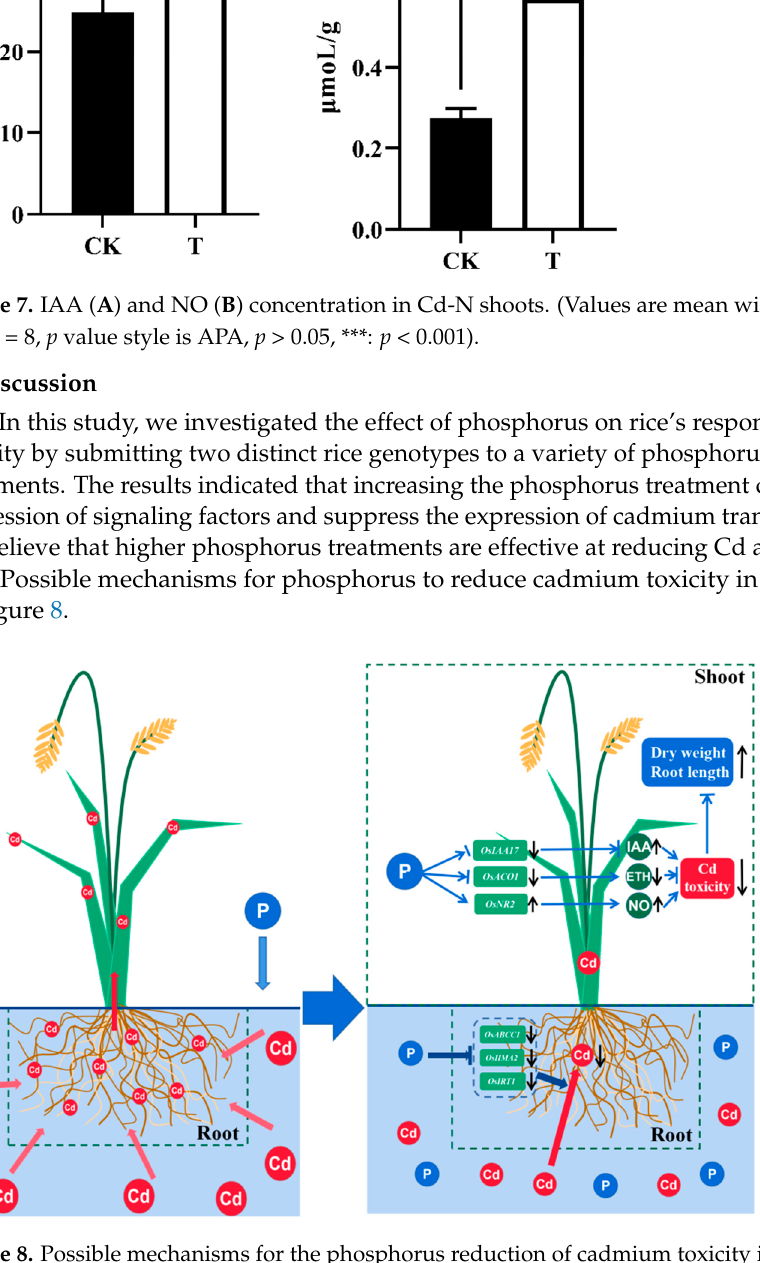
Figure 8. Possible mechanisms for the phosphorus reduction of cadmium toxicity in rice.